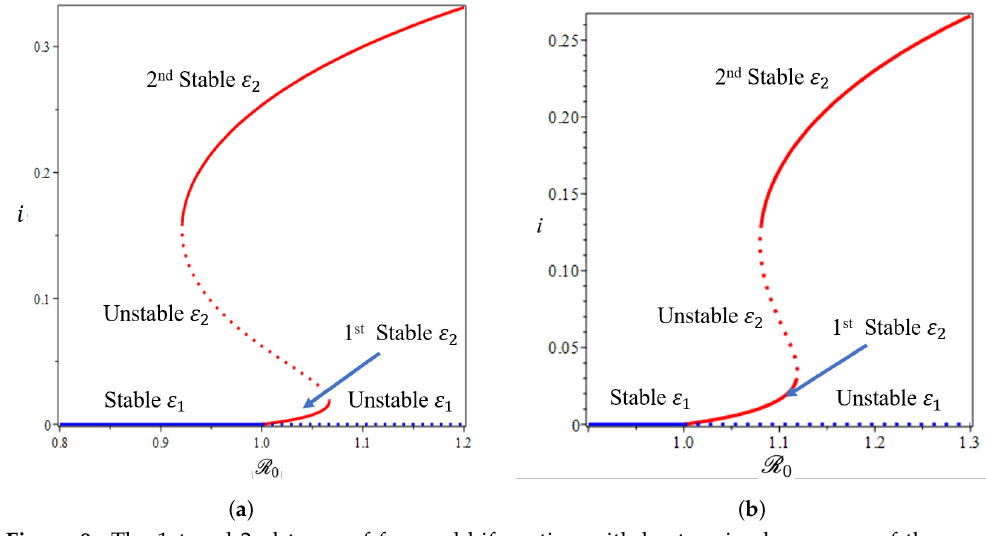
Figure 9. The 1st and 2nd types of forward bifurcation with hysteresis phenomena of the non- dimensionalized malaria model ( a , b ) (see Supplementary Section S1, Equation (S4)) from near R 0 = 1 with ω = 38 and ω = 34,